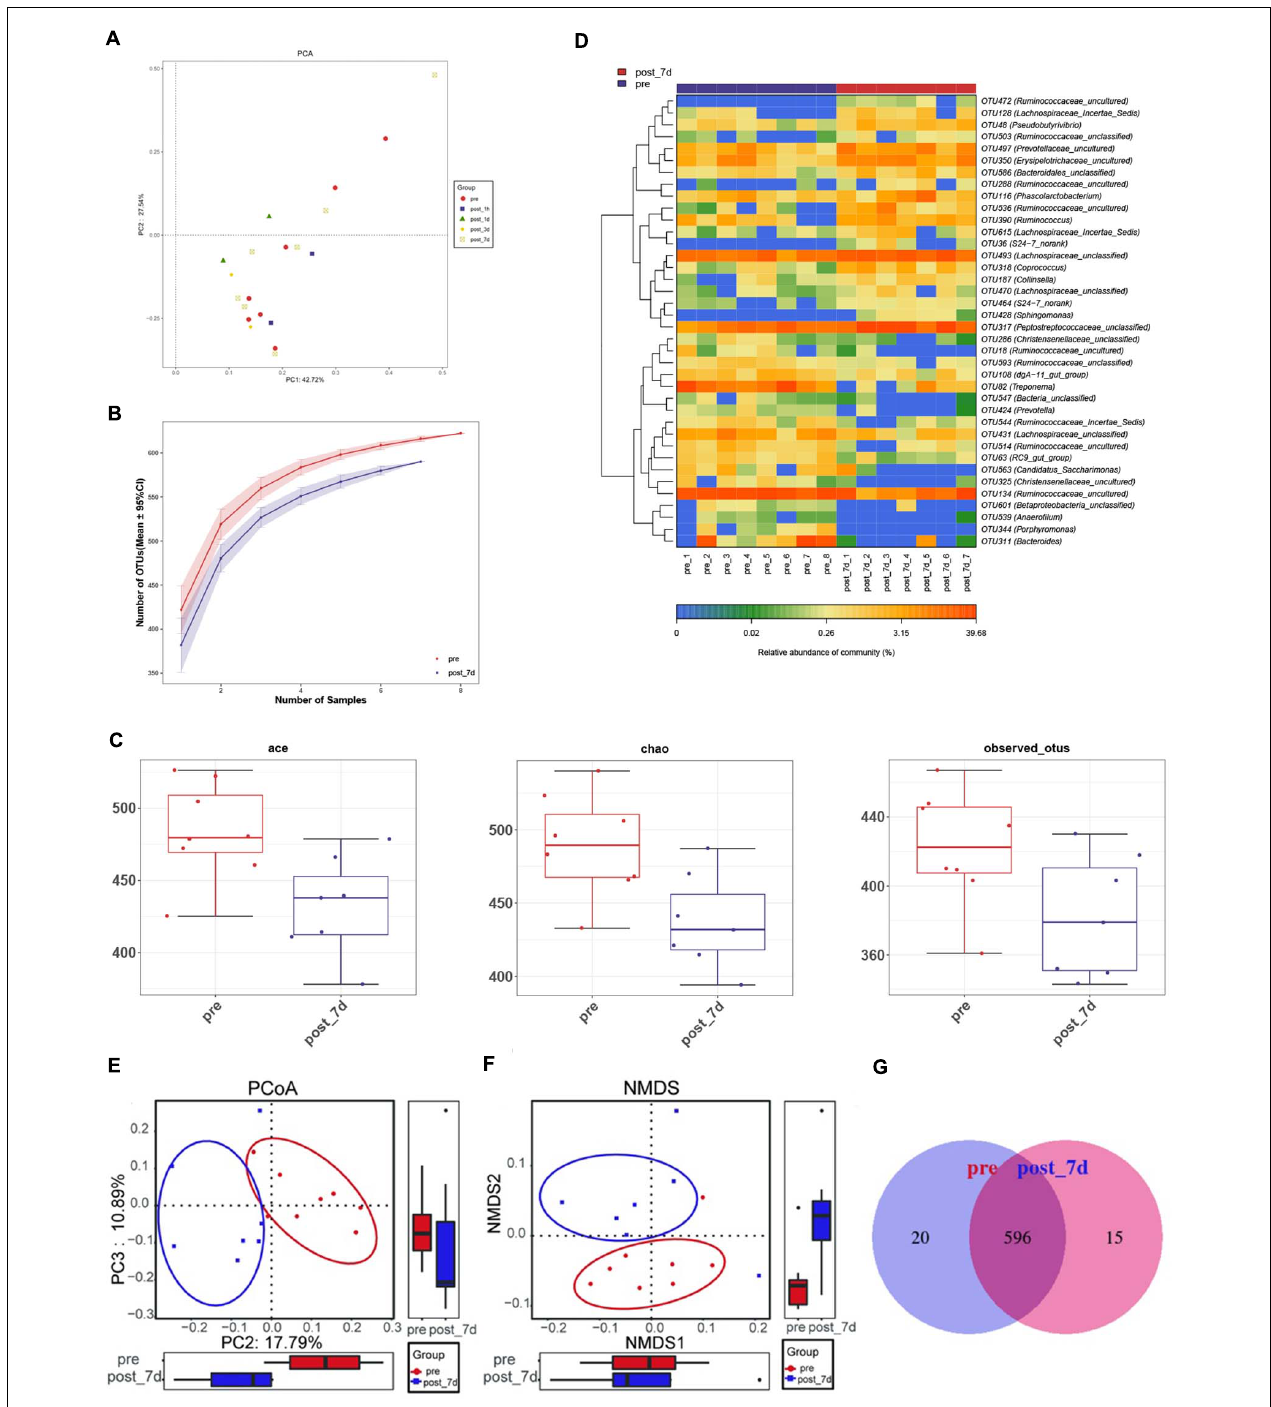
FIGURE 5 | Dynamic changes of faecal microbiota before and after nsPEF treatment. (A) Principal coordinate analysis (PCA) of faecal microbiota between the two groups were conducted. (B) The rarefaction curves for number of reads sampled between the two groups. (C) Comparisons of microbial diversity and richness estimated by Incidence-Based Coverage Estimators (ICE) Index, Chao Index and Observed Species (Obs) Index between the two groups. (D) The heat map shows the mean abundances of the prominent OTUs assigned to genus level between before and after nsPEF treatment. (E) OPLS-DA score plots show the considerable separation between before and after nsPEF treatment. (F) Non-metric multidimensional scaling (NMDS) plot showing alteration in the composition of gut bacterial communities before and after nsPEF treatment. (G) A Venn diagram displaying the overlaps between groups showed that 596 of the total richness of 631 OTUs shared between before and after nsPEF